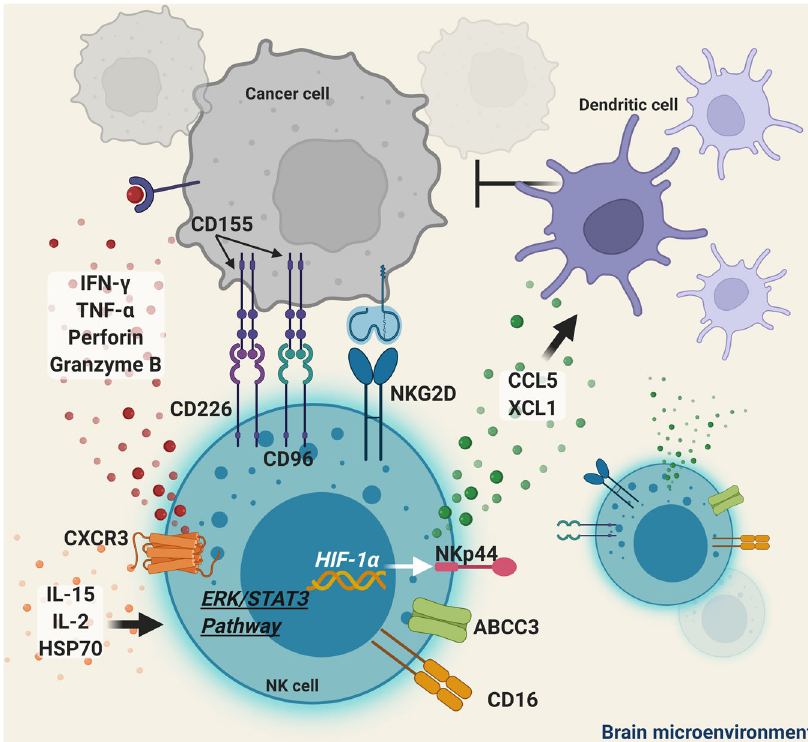
Fig. 2 Mechanisms of NK cell activation in the brain tumor microenvironment. Mechanisms of NK cell activation include the secretion of IFN- γ , TNF- α , perforins, and granzyme B. Cytokines, such as IL-2 and IL-15, can also prime the NK cell immune cytotoxic effect. Protein expression of NKG2D, NKp44, CD226, ABCC3, CD16, CXCR3, and CD96 can help NK cells recognize cancer cell antigens and trigger their cytotoxic tumor cells. The expression of CD1d, an antigen-presenting molecule for NK cells, is common in human glioblastoma but not in glioma stem cells 59 . Retinoic acid upregulates CD1d expression in glioma stem cells in vitro, sensitizing them to NK- mediated cytotoxicity 59 .